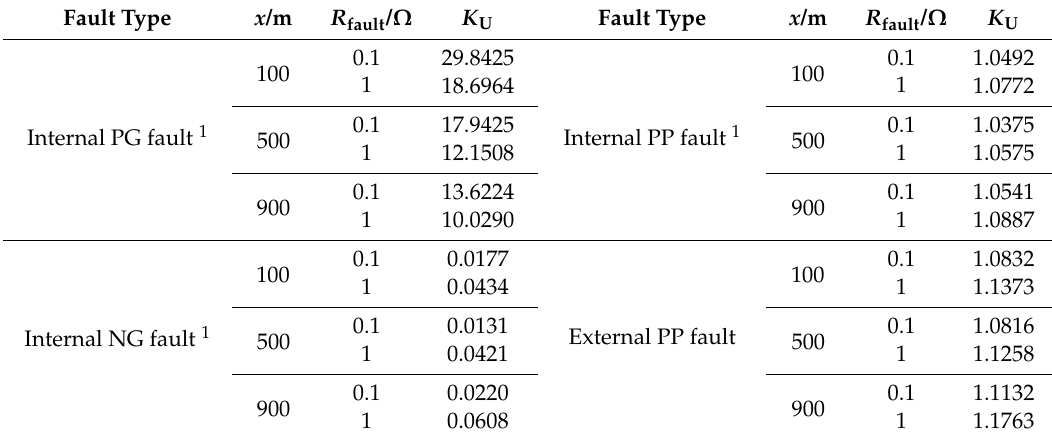
Table 1. Simulation results of faulted pole selection for forward